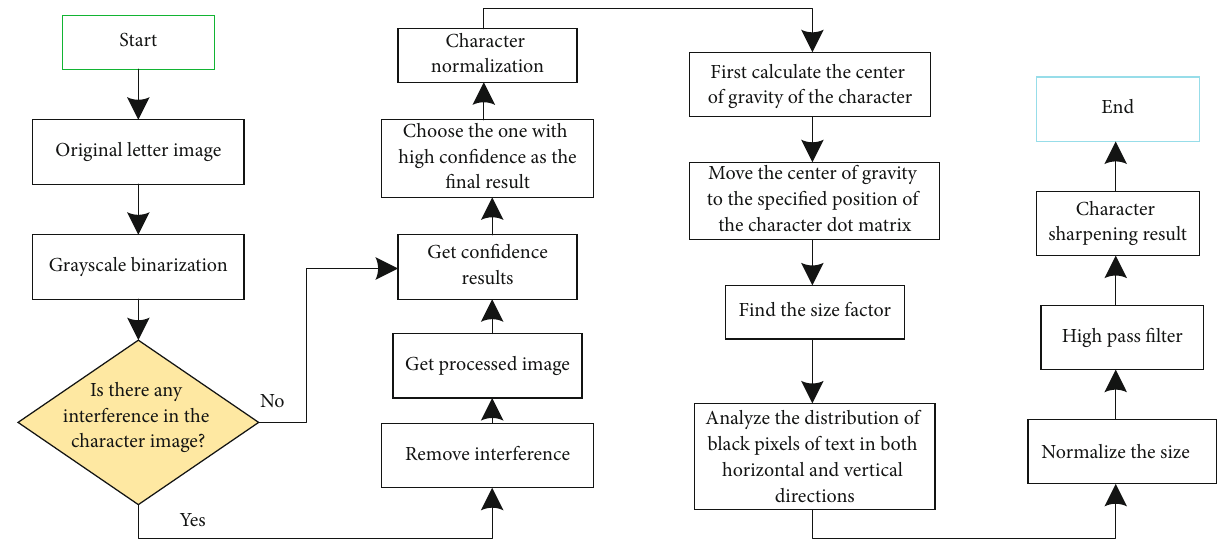
Figure 1: The interference removal process of con fi dence